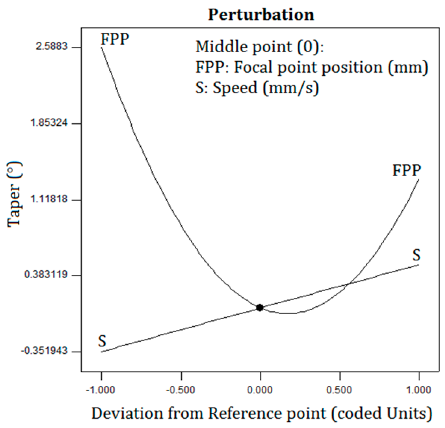
Figure 14. Perturbation plot of the taper.